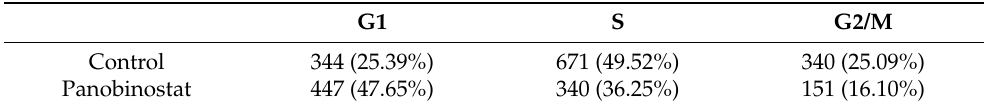
Table 1. Numbers (and percentages) of control cells and panobinostat-treated Kelly cells at different cell cycle phases (inferred in